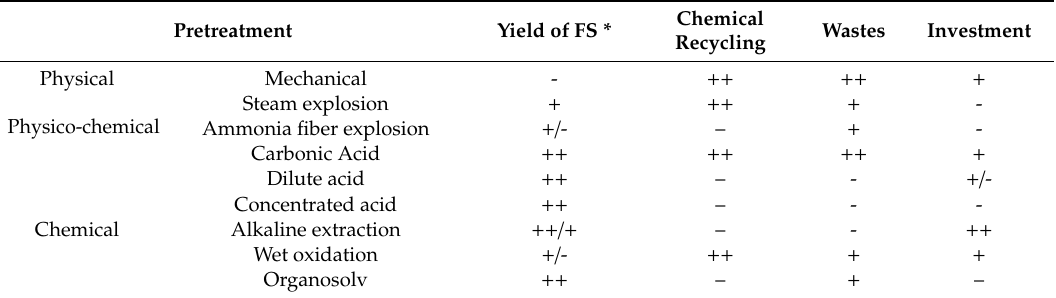
Table 1. Advantages and weaknesses of selected pretreatment processes. Pretreatment Yield of FS *